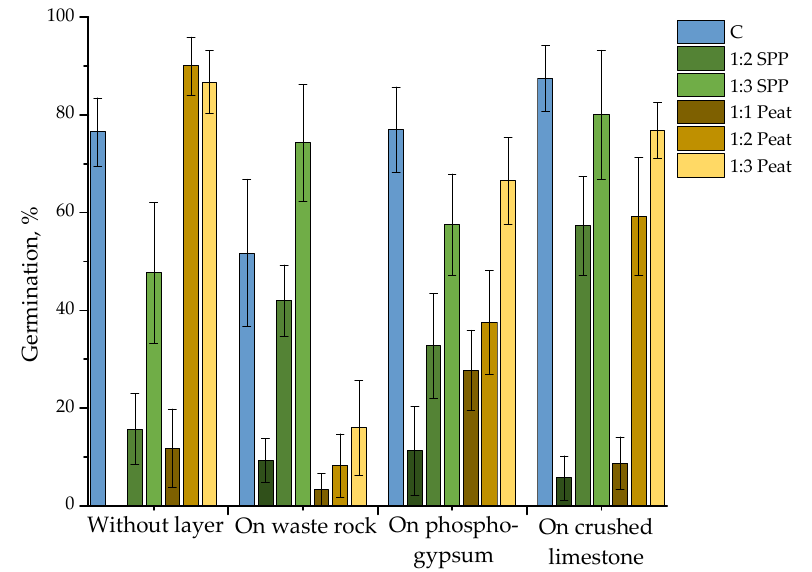
Figure 5. Diagrams of seed germination (%) by four groups of rehabilitation layers with seven types of models—control model (soil), wastewater sludge SPP and peat mixture: A—without layer, B—on waste rock, C—on phosphogypsum, D—on crushed limestone. The data represent the mean of 4 replicates; the vertical bars indicate standard deviations.